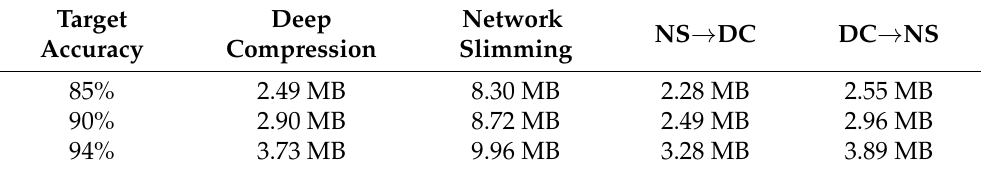
DC and DC NS for DenseNet-121. → →